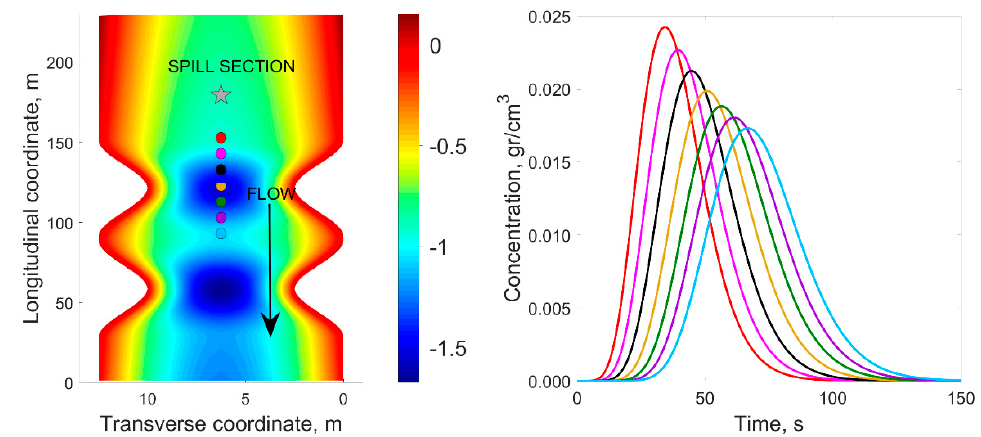
Figure 5. ( a ) Plan view of the sampling points in the synthetic bathymetry domain for the time concentration curves. Pont spacing was 10 m; and ( b ) time-concentration curves for bathymetric setting with ∆ z = 0.494 .